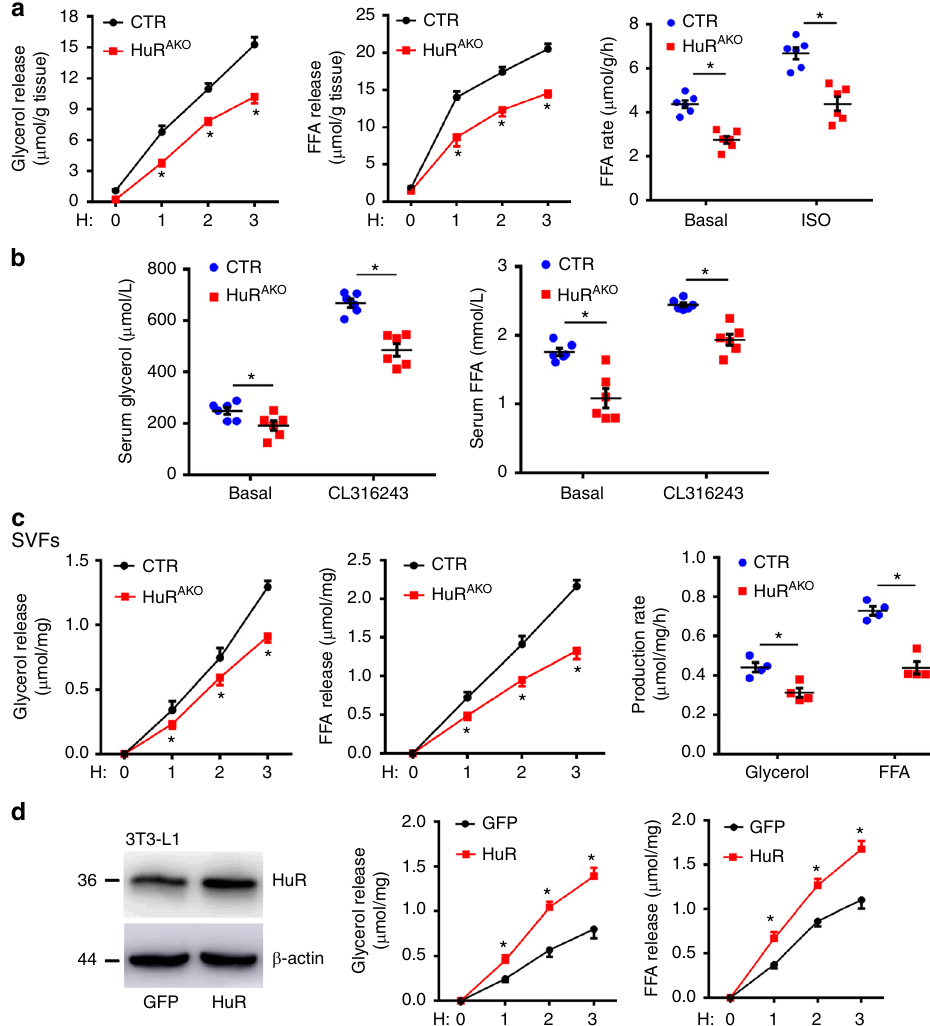
Fig. 4 Adipose-speci fi c HuR ablation suppresses adipocyte lipolysis. a EpiWAT explants were prepared from HFD-fed control and HuR AKO mice, and stimulated with 1 μ M ISO. FFA and glycerol release were measured (normalized to total protein levels). FFA release rates were calculated ( n = 6), *comparison of HuR AKO vs. control. b HFD-fed control and HuR AKO mice were injected with CL316243 (1 mg kg − 1 body weight). Serum FFA and glycerol levels were measured ( n = 6), *comparison of HuR AKO vs. control. c SVFs were isolated from control and HuR AKO mice, differentiated to adipocytes, and stimulated with 10 μ M ISO. Glycerol and FFA release were calculated (normalized to total protein levels) ( n = 4), *comparison of HuR AKO vs. control. d Differentiated 3T3-L1 adipocytes were infected with adenovirus expressing GFP or HuR for 48 h. Cell extracts were immunoblotted with antibodies against HuR and β -actin. Adipocytes were stimulated with 10 μ M ISO, and FFA and glycerol release were calculated (normalized to total protein levels) ( n = 4), *comparison of HuR vs. GFP. Data are represented as mean ± SEM. Signi fi cance was determined by Student ’ s t test analysis, * P < 0.05. Source data are provided as a Source Data fi